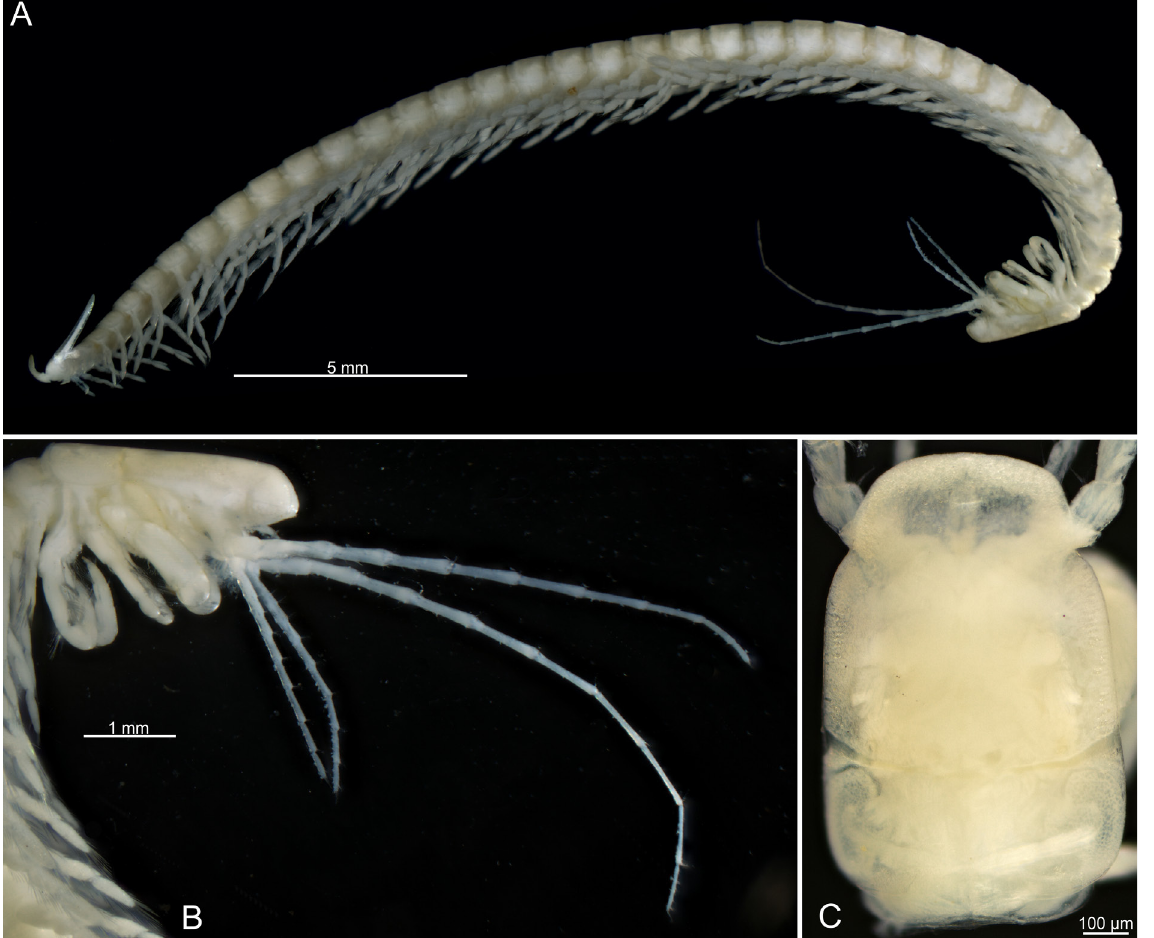
Fig. 3. Xibalbanus cozumelensis sp. nov., light microscopy. A . Holotype, adult specimen, lateral view (ZMUC-CRU-4791). B . Holotype, cephalon, lateral view. C . Paratype, cephalon, dorsal view (ZMUC-